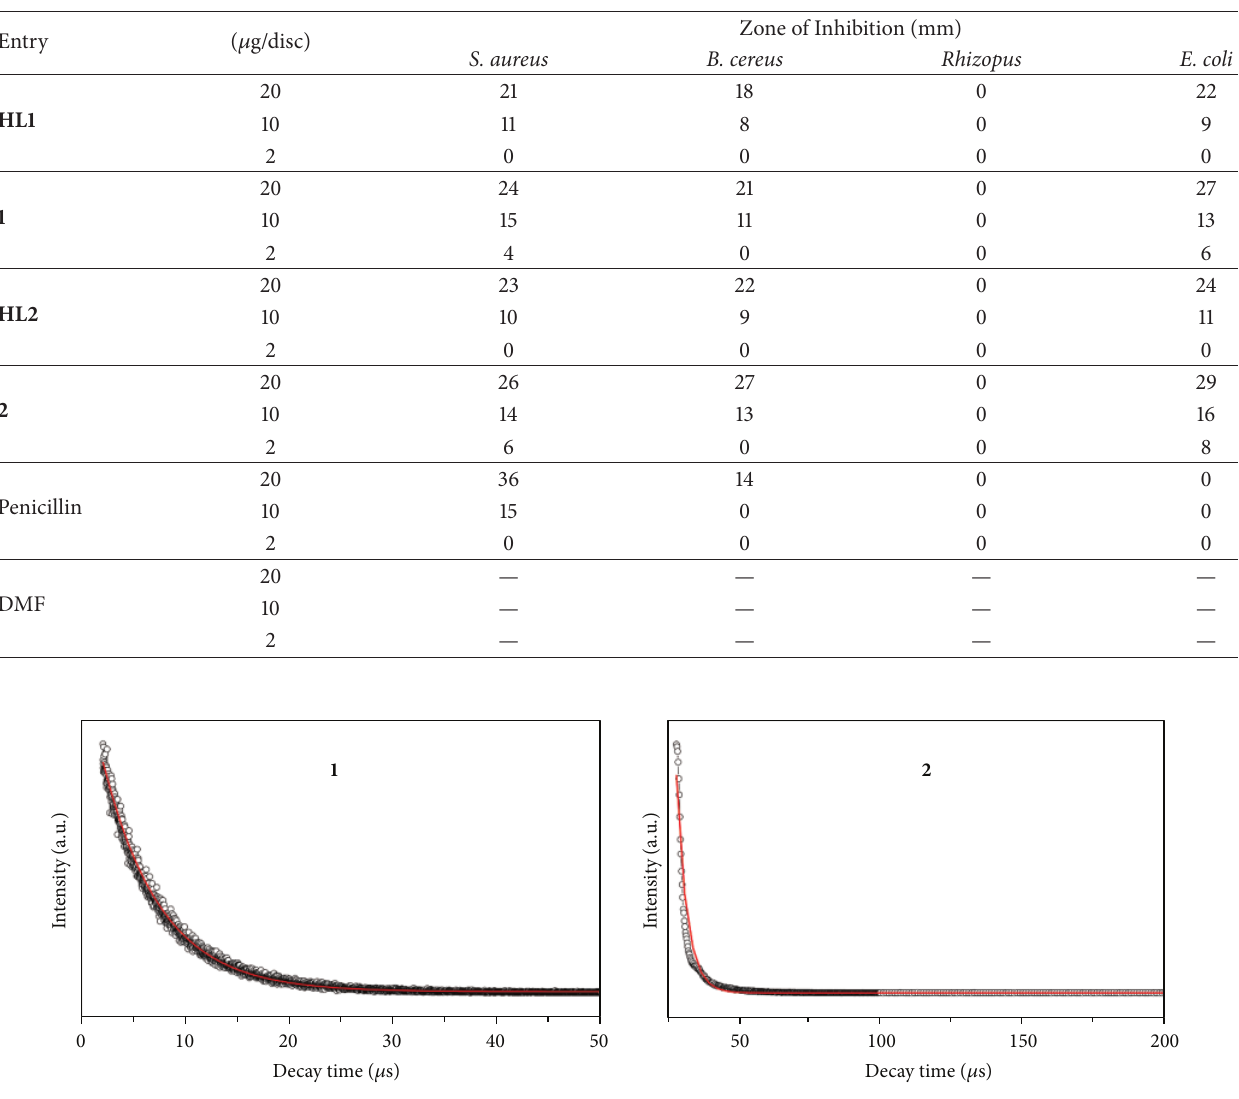
Table 4: Antibacterial activities of the ligands and complexes.